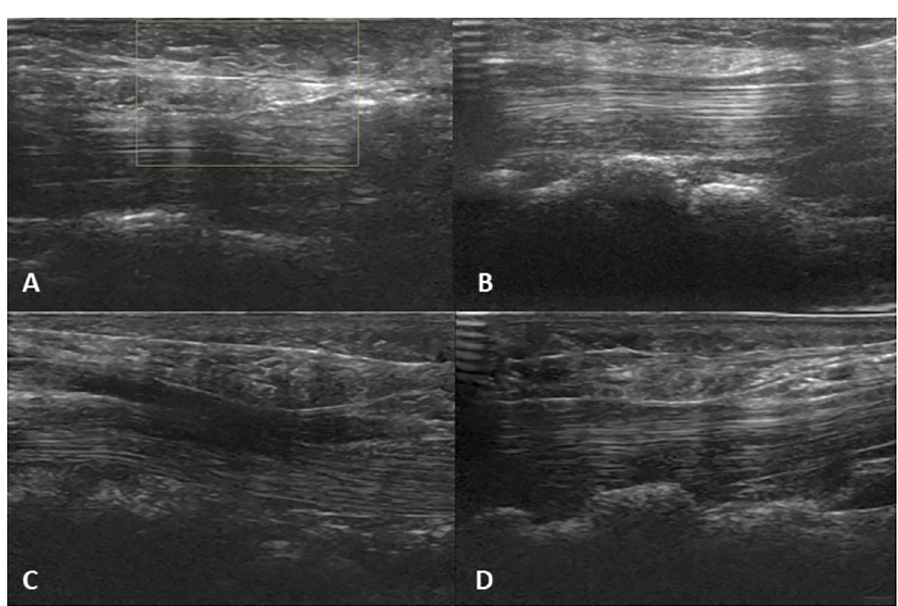
Fig 6. Realtime ultrasound images of both threads visualized during TCTR procedure. A, B: Loop & Shear thread. C, D: Smartwire-01. We could visualize the newly developed thread with higher acuity in ultrasonographic imaging compared to the commercial